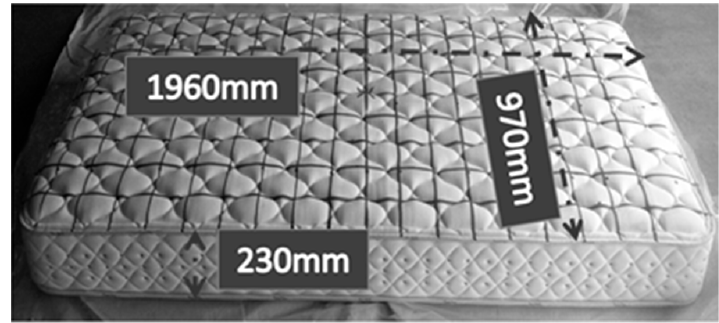
Figure 1. Bed-mattress dimensions.